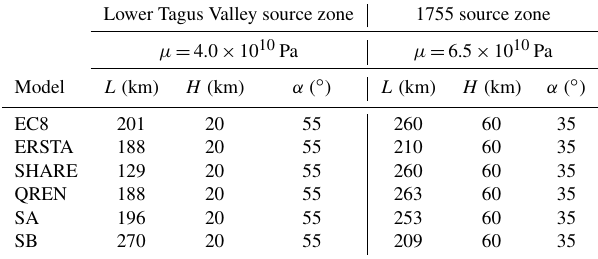
Table 5. Source zone parameters for the simplified sanity check. L stands for the source zone geometry; H and µ are the thickness and the mean shear modulus for the seismogenic layer, respectively. α is the dip of the fault.